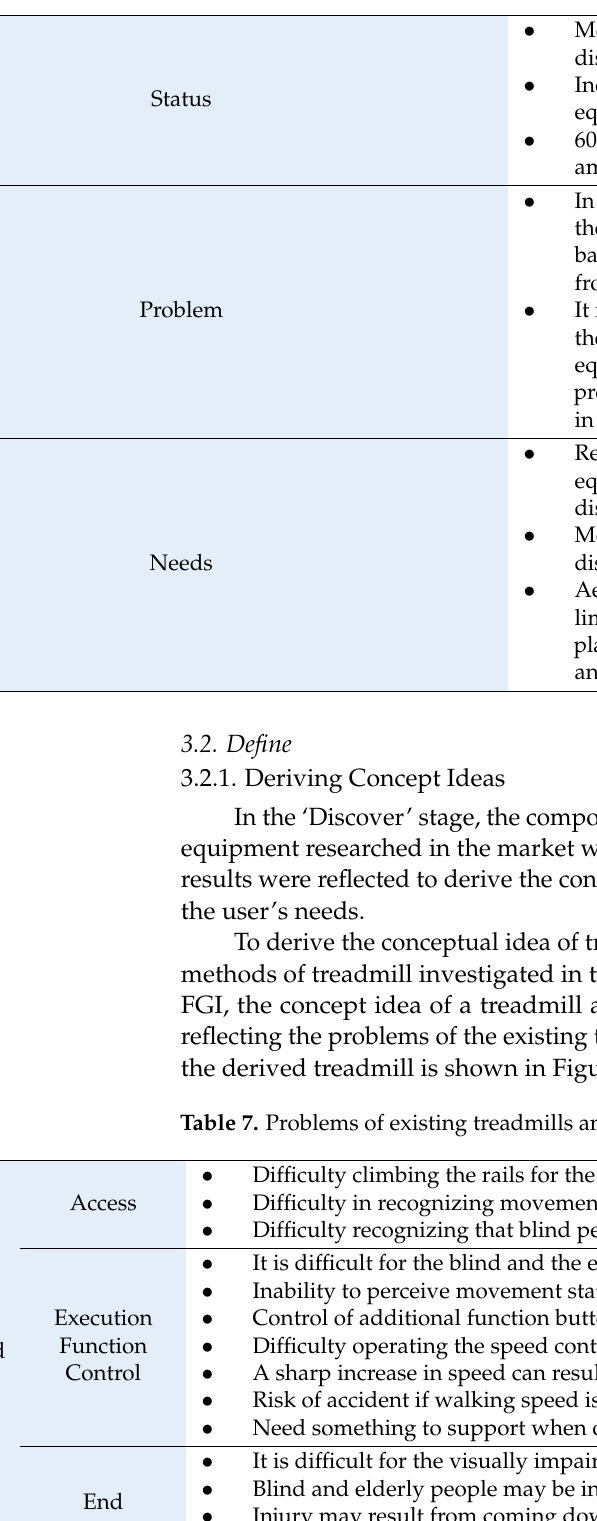
Table 6. Aerobic exercise equipment FGI results of sports facilities.